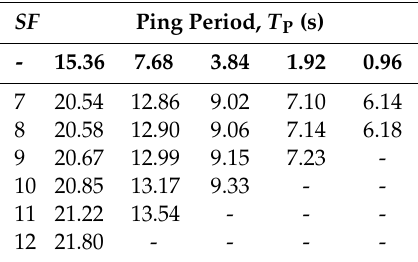
Figure 9. Maximum number of coordinated IPSs for each SF (considering the use of all the three compulsory LoRaWAN channels) depending on the selected ping period, in the scenario with up to 32 mapped devices. SF: Spreading Factor. Table 5. Maximum expected response time for each SF depending on the selected ping period, in the scenario with up to 32 mapped devices. SF : Spreading